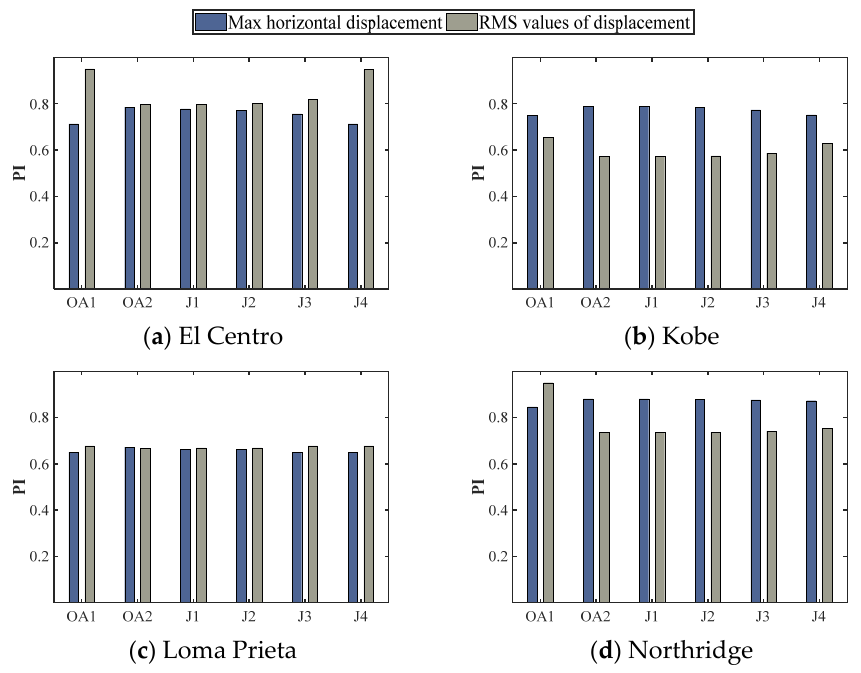
Figure 12. PI values for every optimization approach using TMDs with μ = 0.05.